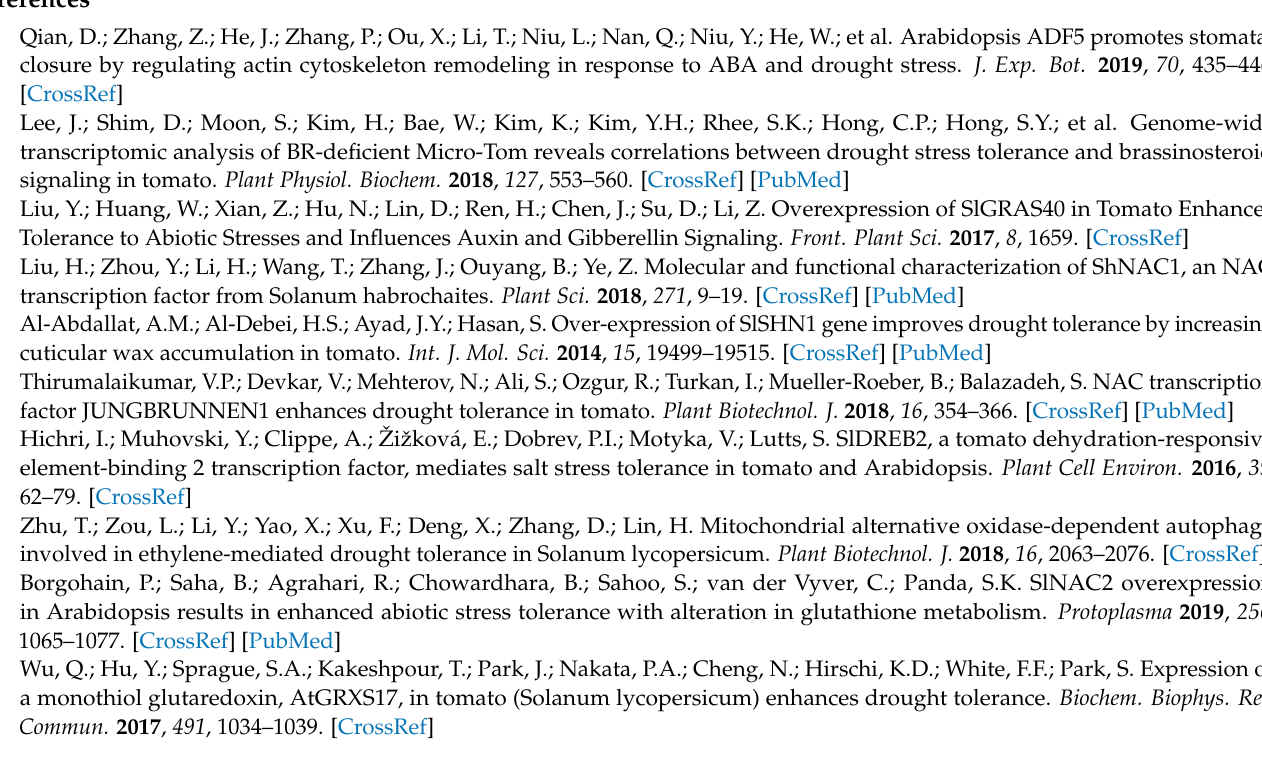
samples in tomato under different treatments. The WT and arf4 (ARF4) mutant grown under water stress are represented by WT-D and arf4-D (ARF4-D), respectively. Figure S3. Gene expression associated with plant hormone signal transduction pathways in arf4 mutants grown under water stress. The red box represents differently expressed genes. Figure S4. Gene expression of arf4 mutants in Phenylpropanoid biosynthesis pathway under water stress. The red box represents differently expressed genes. Figure S5. Two set of specific differentially expressed genes involved in ABA and salicylic acid (SA) signaling pathways. The red box represents differently genes. Figure S6. Auxin response element analysis of 3000 bp upstream promoters’ sequences of ABi5 , SCL3 , EXO and solyc07g055460.3. Figure S6. Comparison between fluorescent qRT-PCR and transcriptome sequencing results for 13 selected genes. ARF4 represents the arf4 mutant. Figure S7. Pearson’s correlation between RNA-seq data and qRT-PCR data. Table S1. Effect of water stress on stomata morphology of tomato leaf epidermis. Table S2. Summary statistics of RNA-seq data of the 12 libraries mapped to the tomato reference genome ( Solanum lycopersicum ITAG2.3 ). Table S3. KEGG pathways analysis of 628 DEGs. Table S4. KEGG pathways analysis of 86 DEGs. Table S5. KEGG pathways analysis of 32